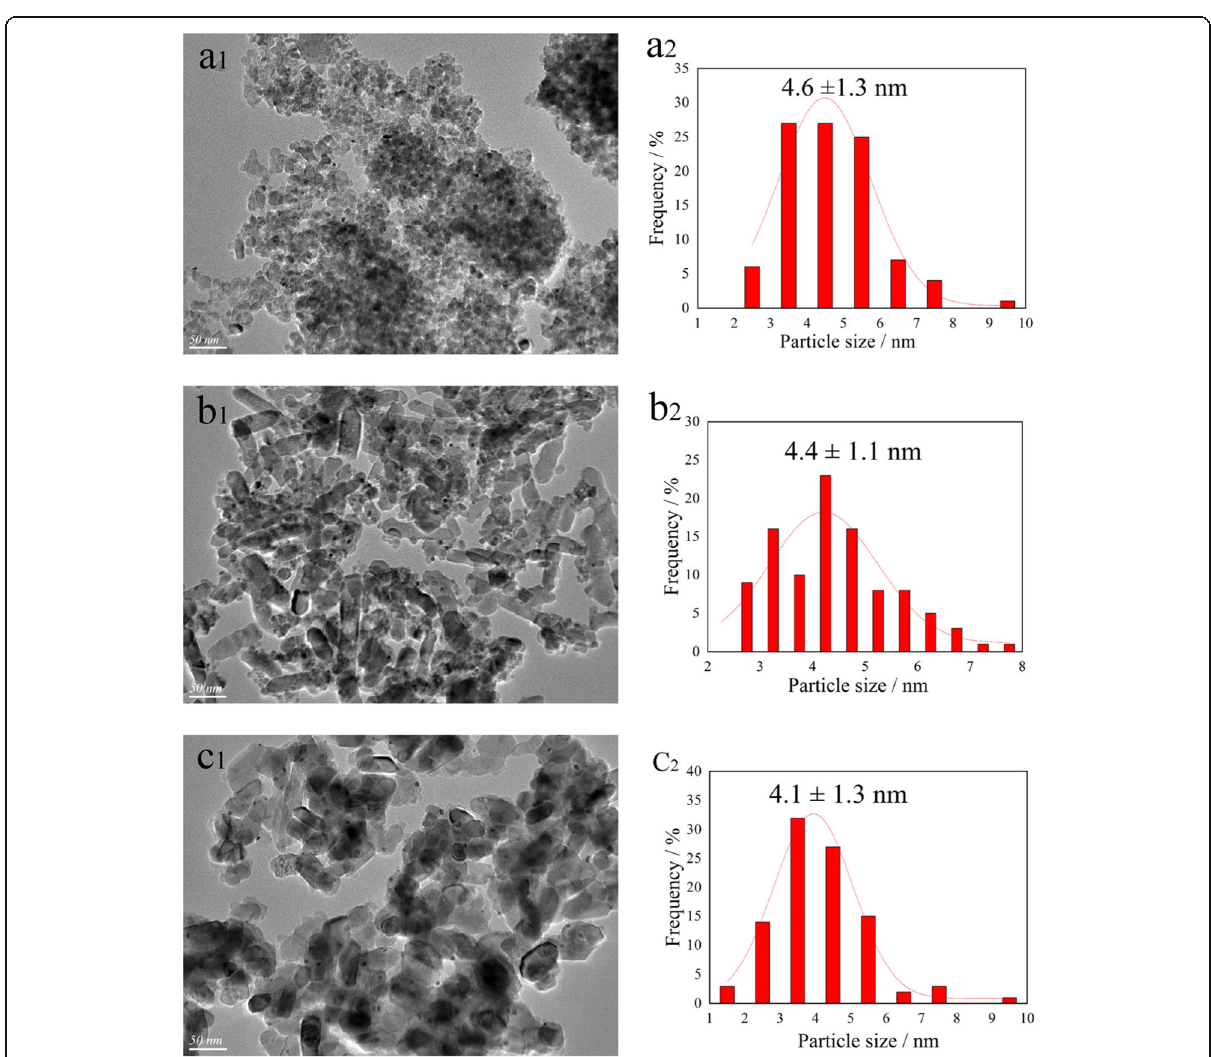
Fig. 3 TEM images and Au-Pd particle size distribution histograms of the ATA ( a 1 , a 2 ), ATB ( b 1 , b 2 ), and ATR ( c 1 , c 2 ) catalysts